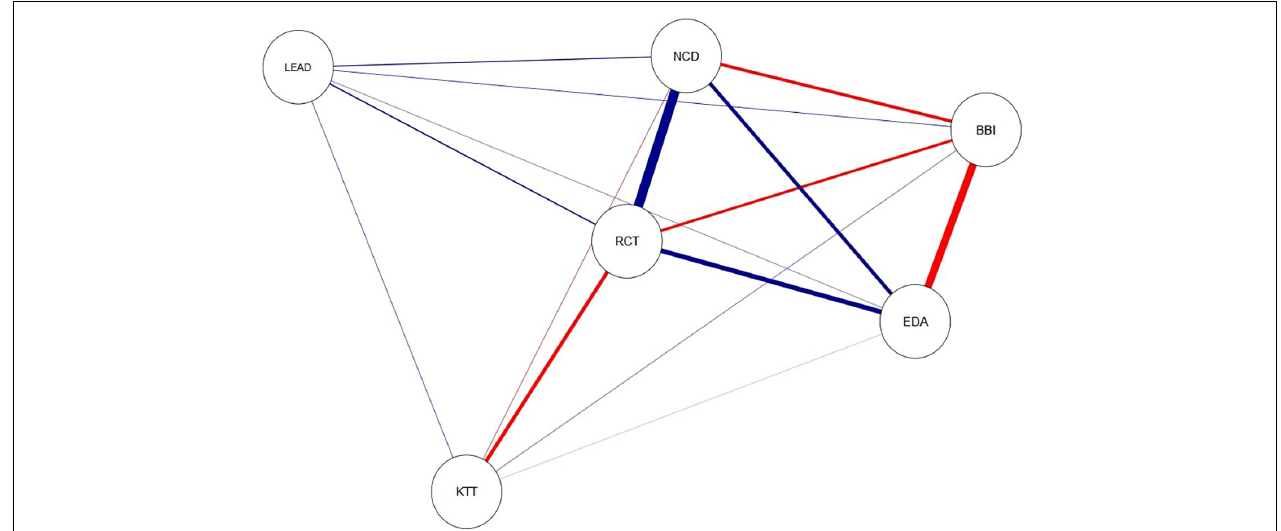
FIGURE 1 | Latent variable correlation network Study 1. Abbreviation RCT refers to reflective-collaborative theory, KTT to knowledge transmission theory. Abbreviation NCD (NCD, new curriculum demands) refers to items measuring the conformity with the new curriculum demands, LEAD to empowering leadership, EDA to work engagement, and BBI to burnout symptoms. Blue edges in the figure refer to positive relations, and red edges to negative relations. The width of the edges corresponds to the absolute value of the correlations: the higher the correlation, the thicker the edge (see Epskamp et al.,